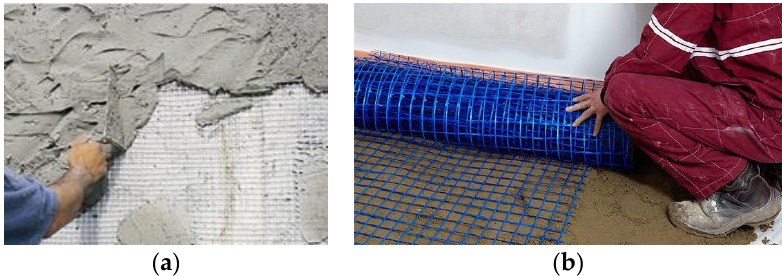
Figure 5. Non-structural applications of polypropylene nets: ( a ) repairing of deteriorated plasters and ( b ) stabilizing the screed before the application of the floor finish.